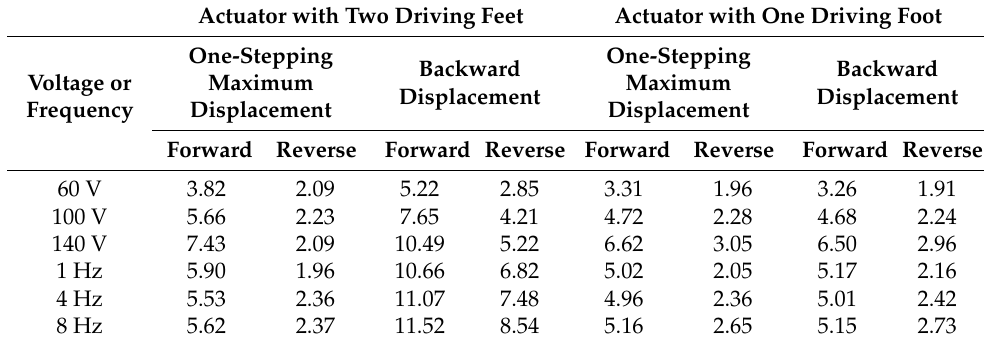
Figure 10. The accumulative displacements of the improved actuator in 10 steps obtained under the fixed driving frequency of 10 Hz and various driving voltages. Table 3. The one-stepping maximum displacement and the backward displacement of the actua- tors with one driving foot and two driving feet under different driving voltages and frequencies (unit: µ